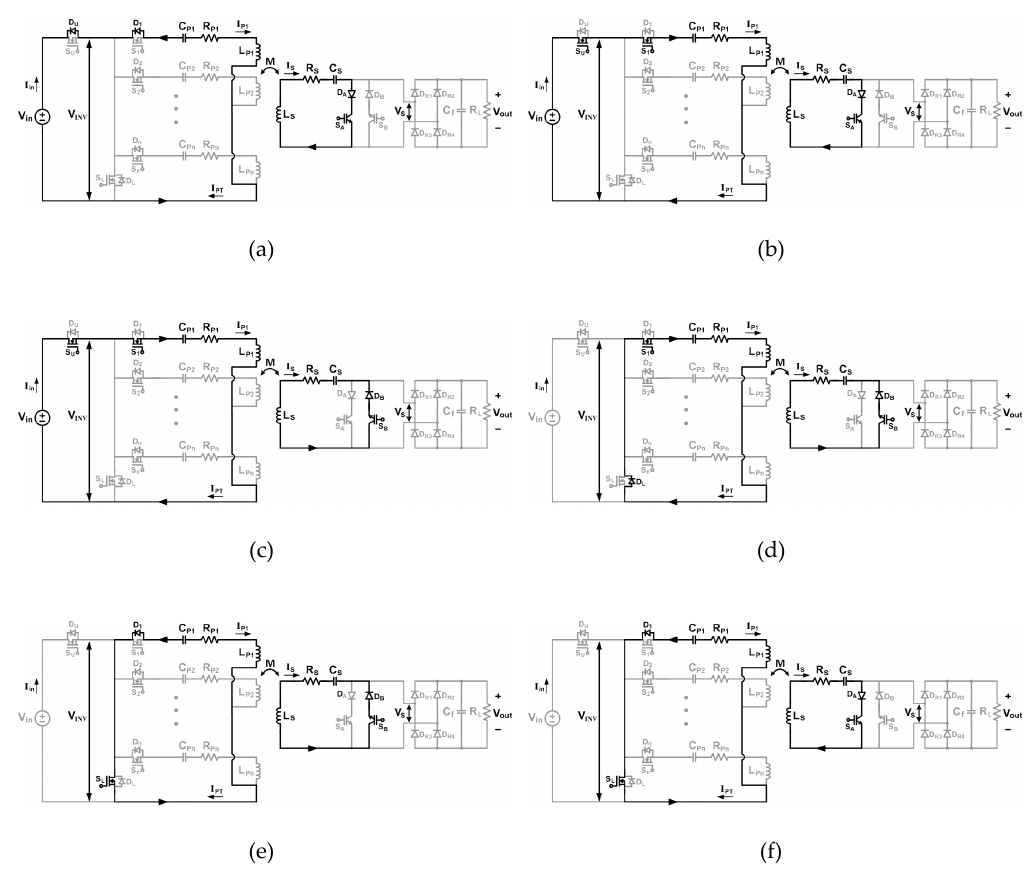
Figure 7. Switching operation of the detection mode: ( a ) Stage 1 [t a –t b ]; ( b ) Stage 2 [t b –t b’ ]; ( c ) Stage 3 [t b’ –t c ]; ( d ) Stage 4 [t c –t d ]; ( e ) Stage 5 [t d –t d’ ]; ( f ) Stage 6 [t d’ –t e ].